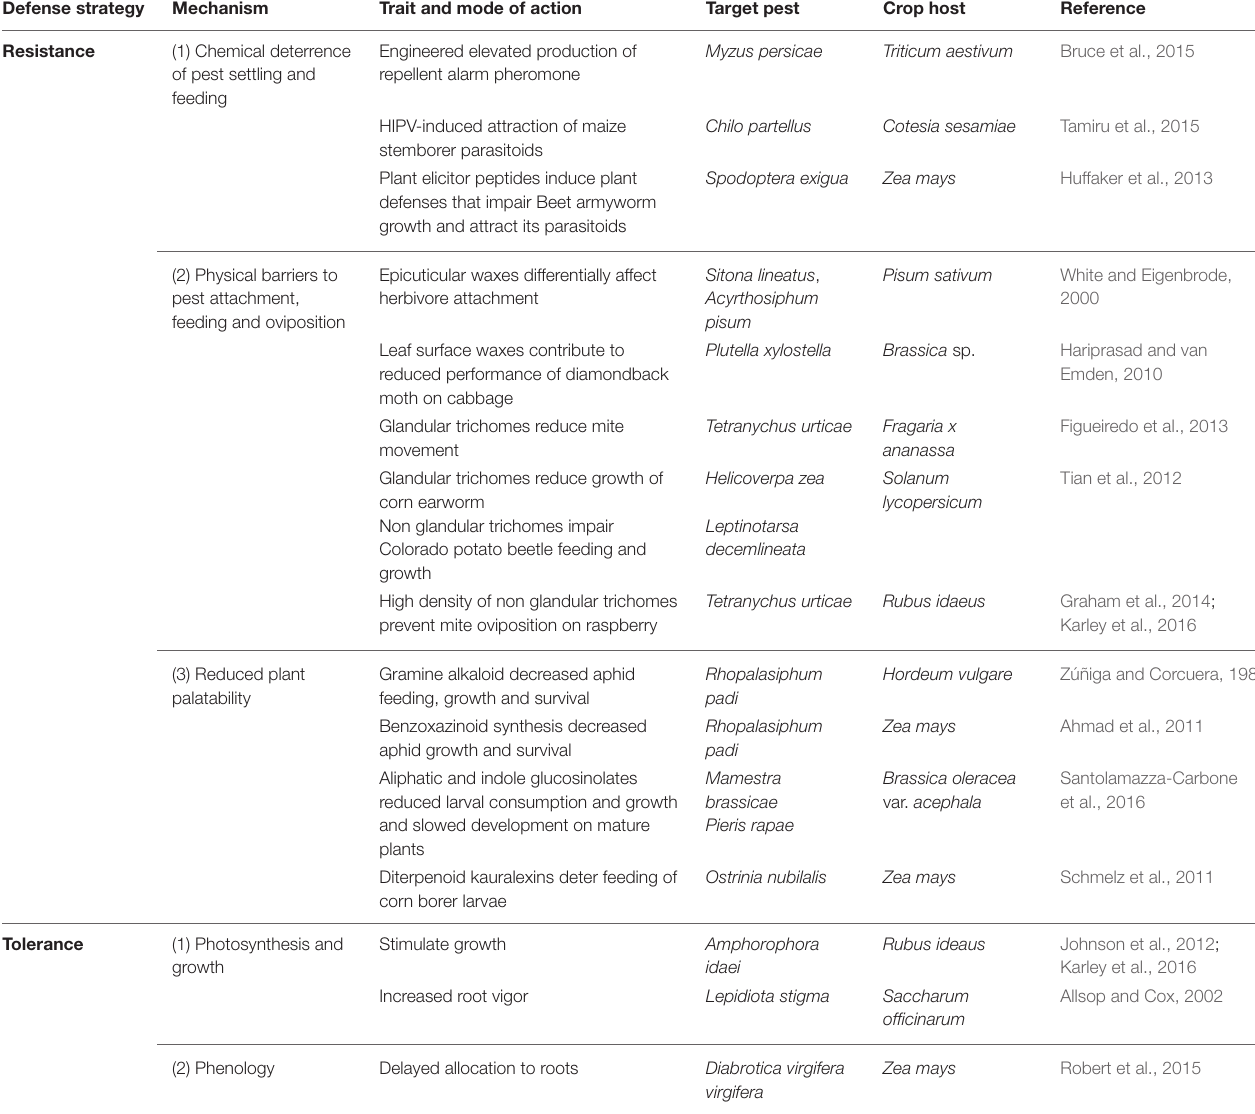
TABLE 1 | Examples of traits and underpinning mechanisms conferring crop resistance or tolerance to target arthropod